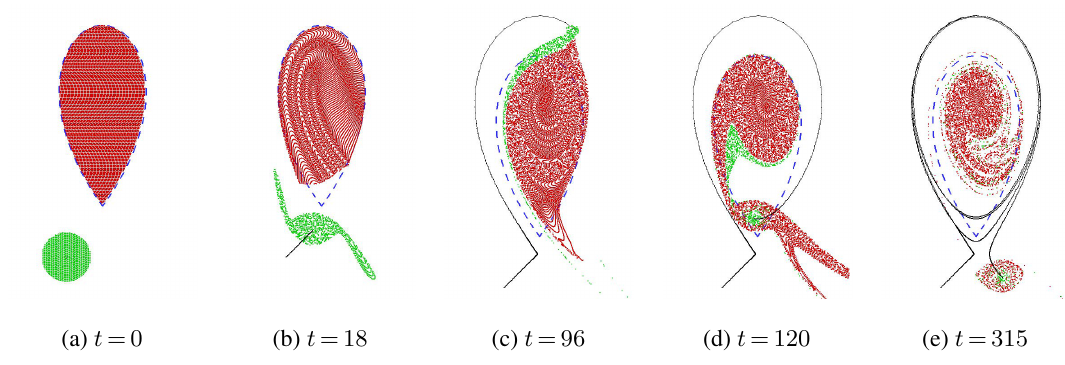
Fig. 12. The same as in Fig. 11 for the middle-layer monopole Fig. 12: The same as in fig. 11 for the middle-layer monopole case.